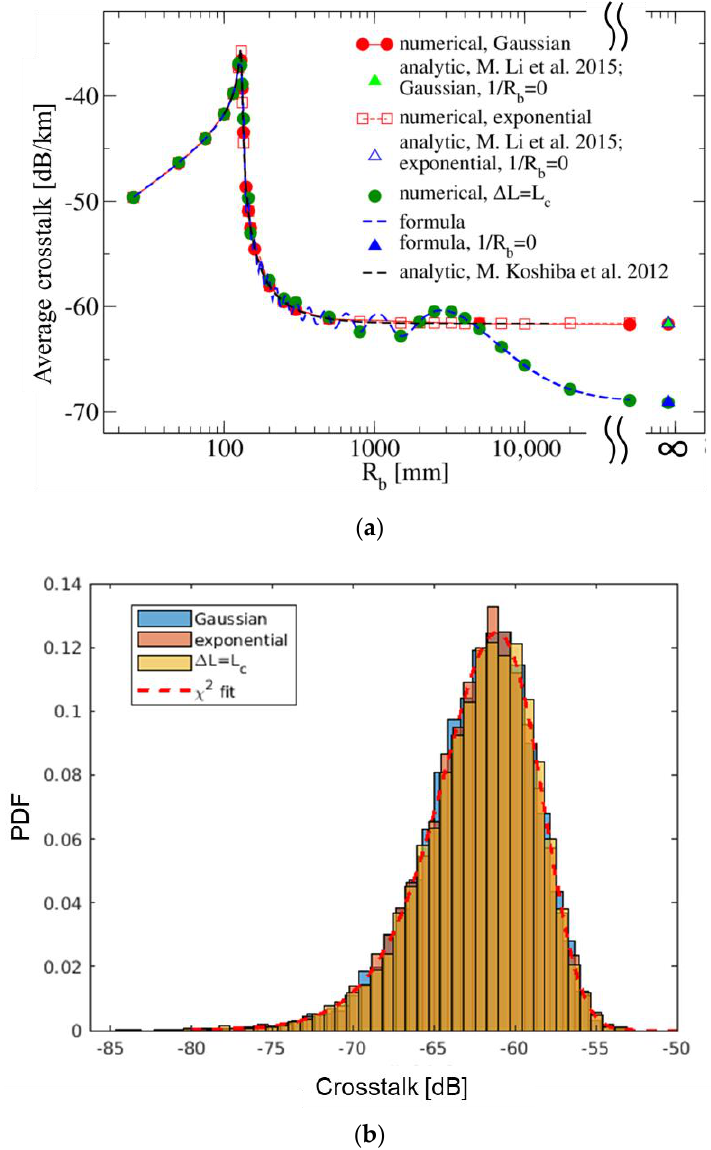
Figure 11. ( a ) Average crosstalk dependence on the bend radius computed analytically according to M. Koshiba et al. 2012 [11], M. Li et al. 2015 [8], numerically and based on Equation (15), for hetero- geneous cores with ∆ n eff = 5 × 10 −4 ; ( b ) simulated crosstalk probability density functions for hetero- geneous MCF at R b = 500 mm in comparison to the χ 2 -distribution function.